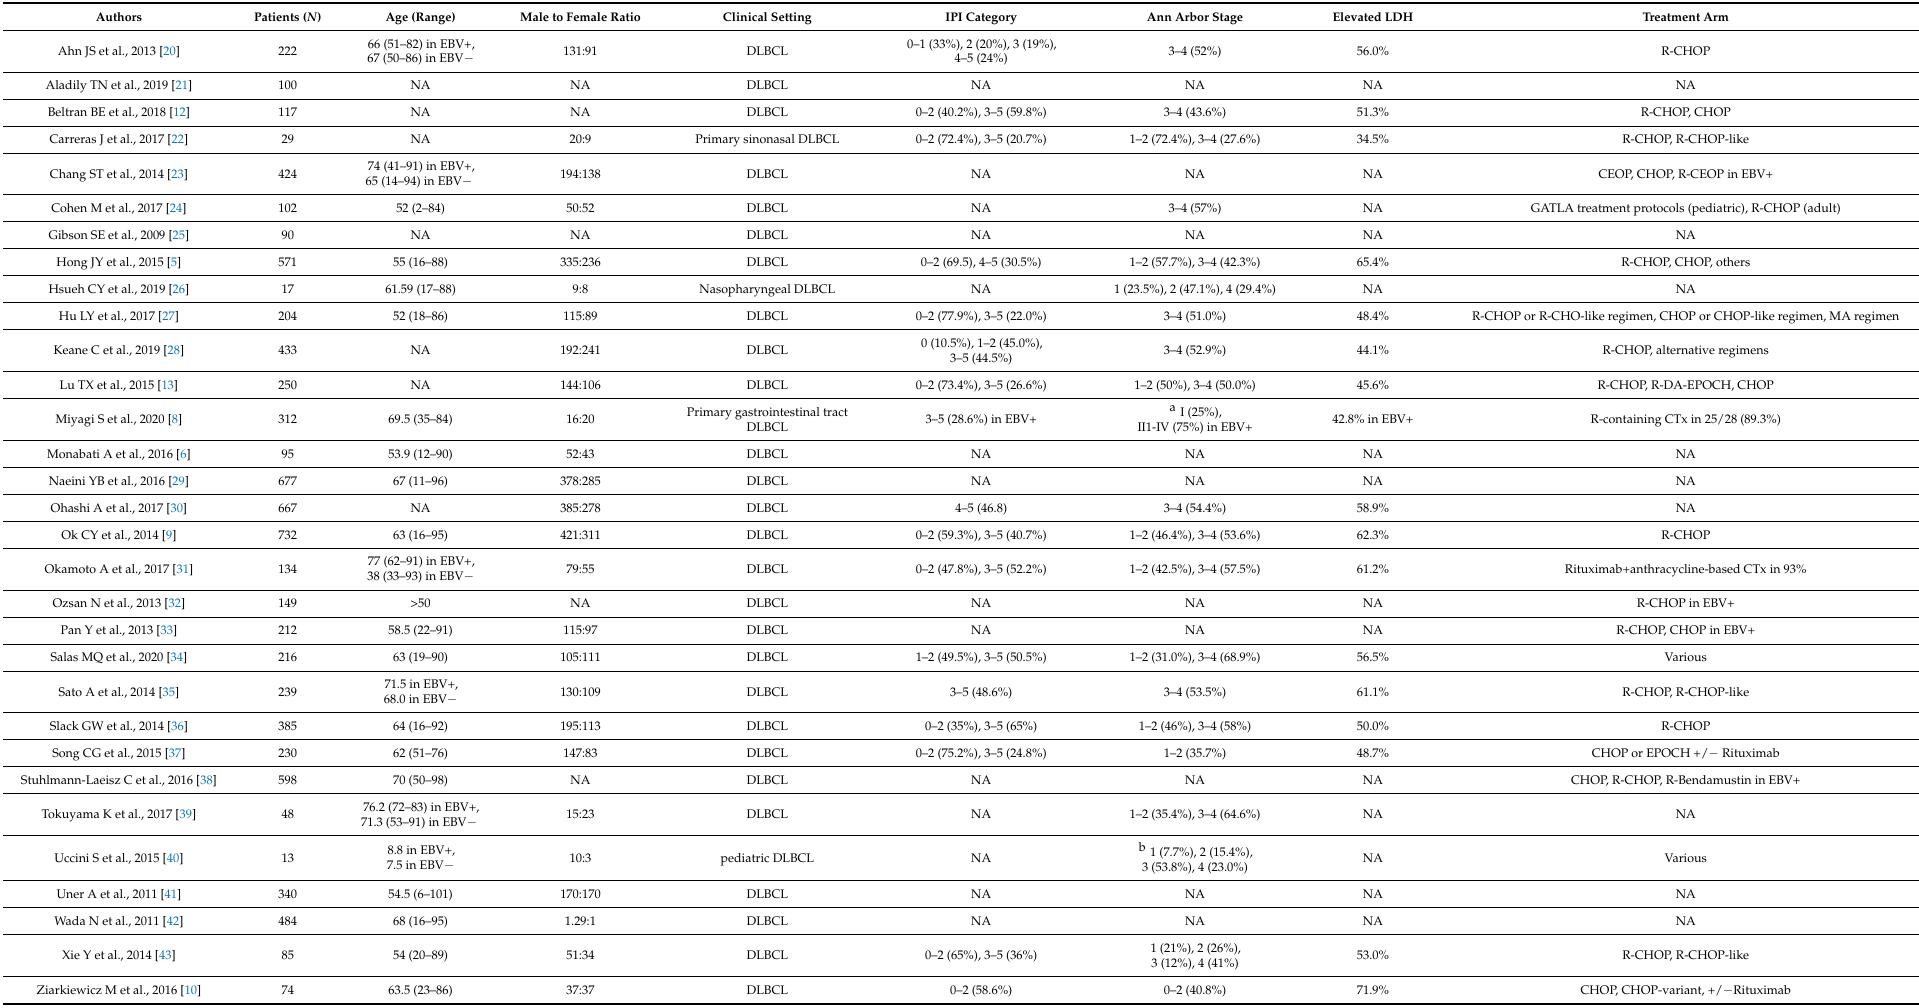
Table 2. Patient characteristics of the included